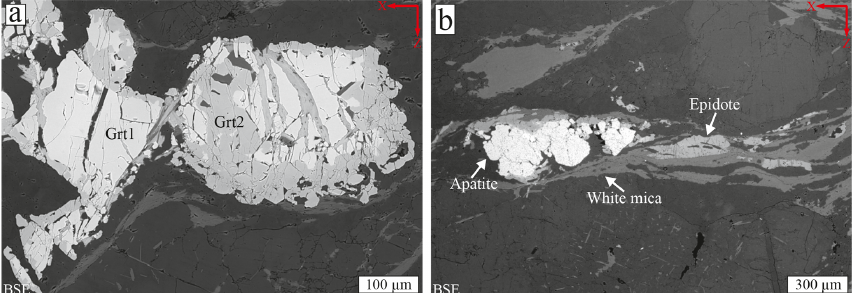
Figure 3. Backscattered electron (BSE) images from sample FH27 showing the typical accessory mineral assemblage in the deformed pegmatites: (a) Ca-rich garnet (Grt2) replacing magmatic Fe-rich garnet (Grt1). (b) Epidote and white mica aligned in the foliation with apatite